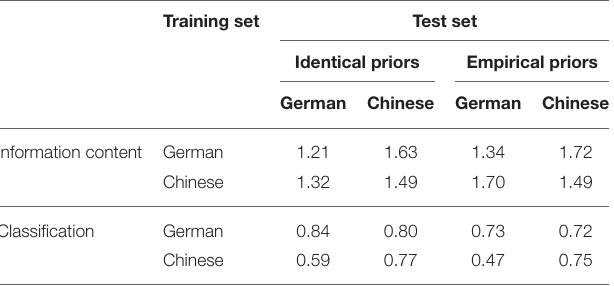
TABLE 4 | Average information content and classification performance of models trained and evaluated on test sets with rhythms from Germany and China.